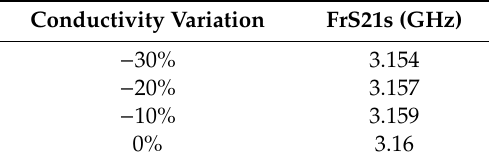
Table 4. Variation of the conductivity as a function of the resonance